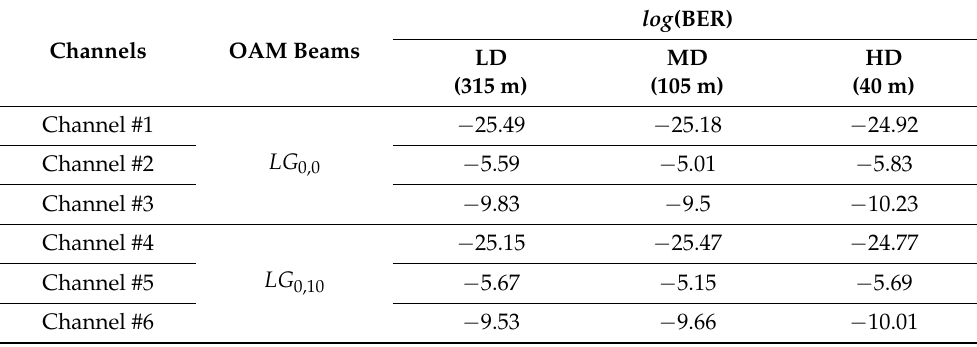
Table 7. Log (BER) values under different dust conditions for OAM/OCDMA-FSO system for six